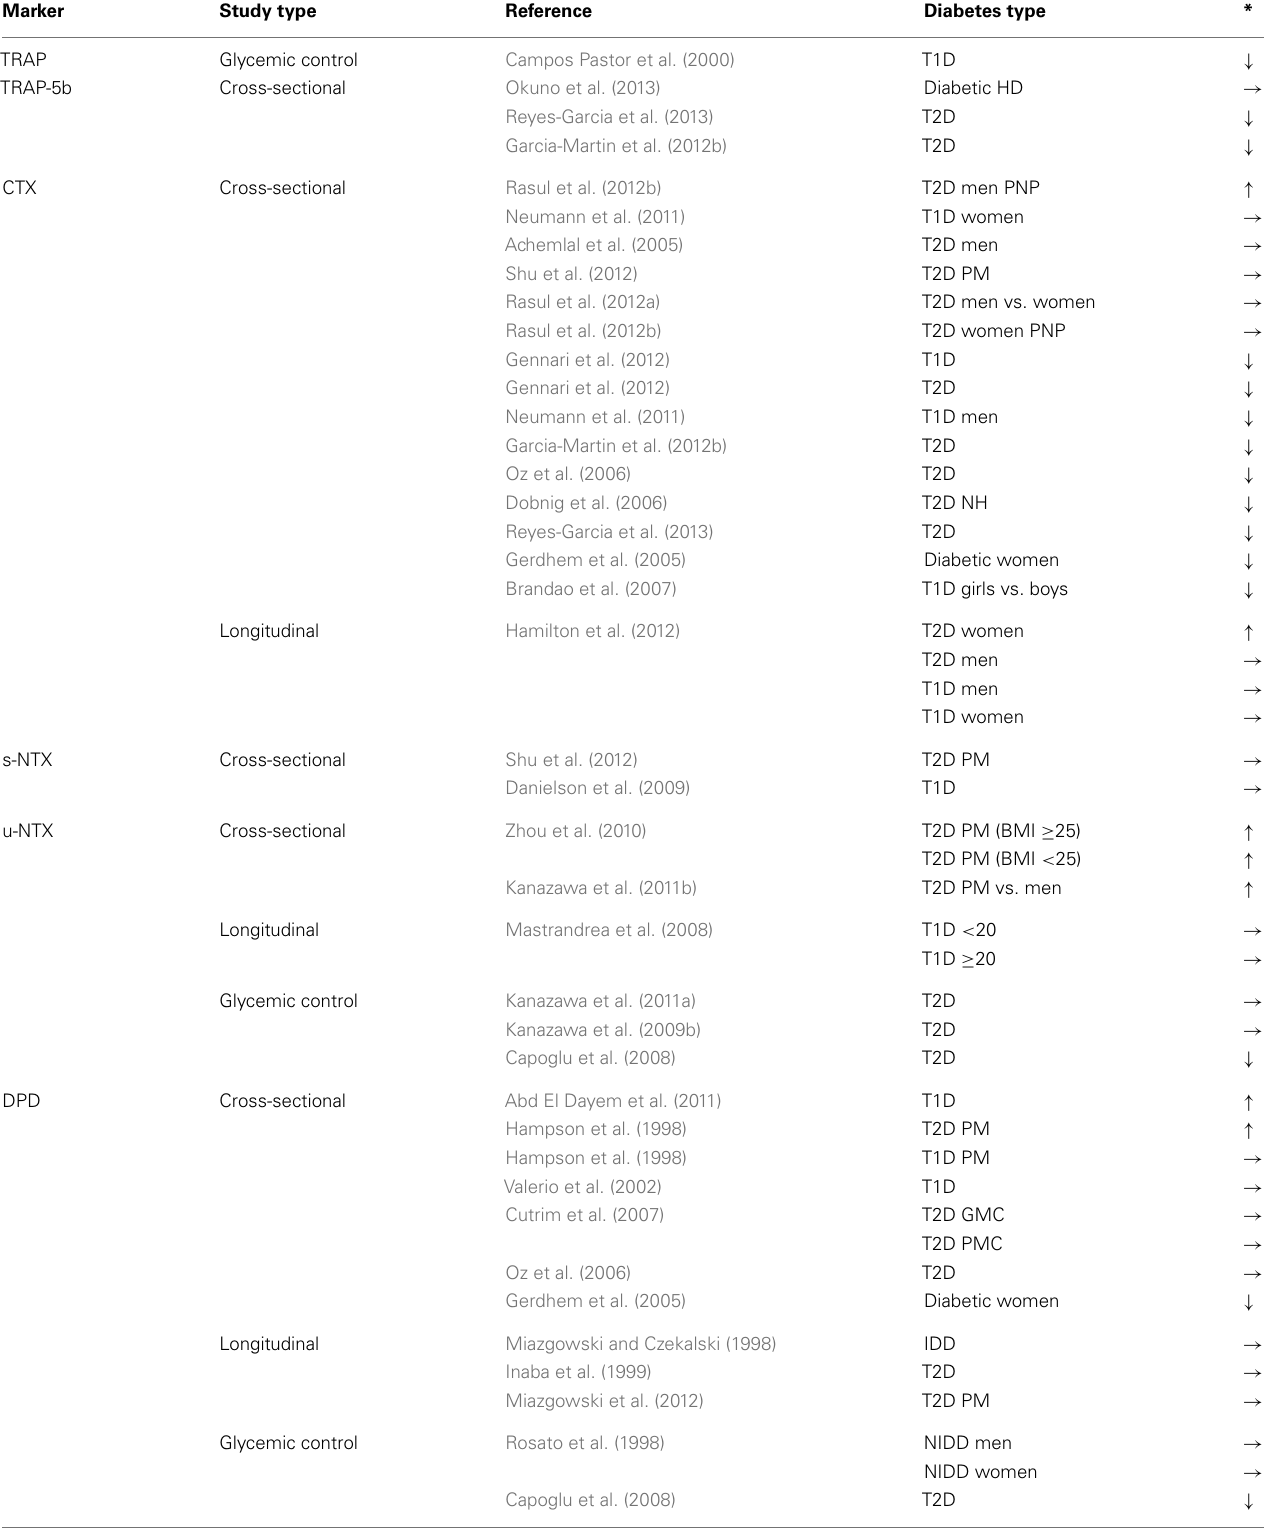
Table 3 | Bone resorption